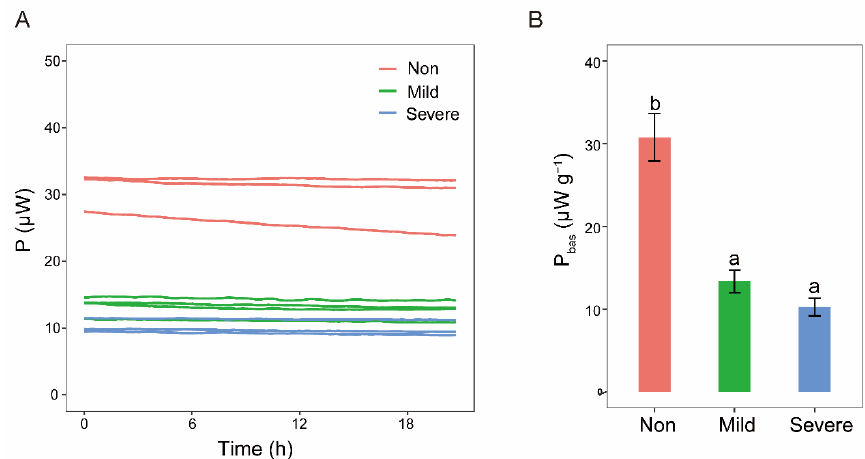
Figure 7. Basal heat release curves ( A ) and average basal heat release P bas with the unit of μW g − 1 ( B ) of the soils with three salinity levels: Non–salinity, Mild–salinity and Severe–salinity. Different letters above bars denote significant differences ( p < 0.05) among salinity levels.